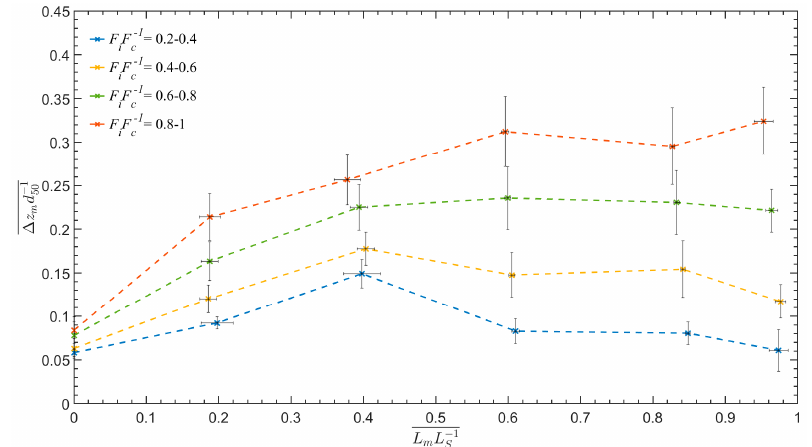
Figure 10. Results of the analysis from the five experimental tests, displaying the average normalized stone displacements along the z -axis ( ∆ z ) and along the x -axis ( L m L − 1 s ). The displacements are presented for incremental normalized load values ( F i F − 1 c ) during overtopping. The uncertainties are displayed according to 95% confidence intervals.